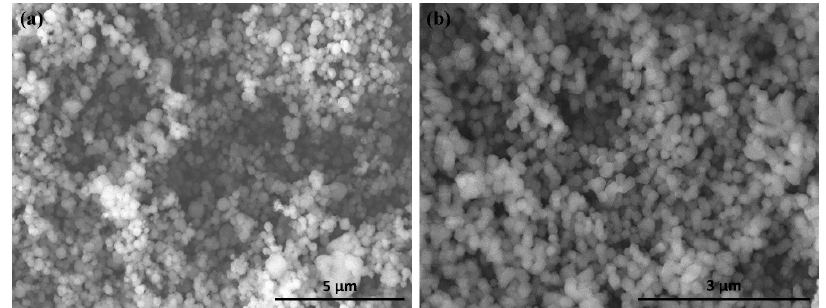
Figure 2. ( a ) Adsorption efficiency of heparin over ZIF-8 vs. ZIF-67 (conditions: 50 mL of 1000 mg L −1 heparin standard solution and 0.5 g of the adsorbent); ( b ) FTIR spectra of standard heparin, ZIF- 8, and preabsorbed heparin on the ZIF-8. 2.2. Heparin Adsorption Studies Prior to optimization, it was important to evaluate the affinity of heparin toward each absorbent in a pure heparin solution. The results (Figure 2a) demonstrated that ZIF-8 could adsorb more than 2-fold more heparin compared to ZIF-67 in a pure aqueous solu- tion. The reported BET surface areas for ZIF-8 and ZIF-67 are >1300 and ~316 m 2 /g, respec- tively [31,32], which are well correlated with their differences in adsorption efficiency. Due to the superior adsorption capabilities of ZIF-8 over ZIF-67, ZIF-8 was selected for further experiments to evaluate adsorption in real samples containing porcine intestinal mucosa. The FTIR spectrum of ZIF-8 shows a band at 1712 cm −1 , which confirms the pres- ence of C=N bond stretching. The bands at 1100 cm −1 and 990 cm −1 are attributed to C-N stretching. Additionally, a preabsorbed sample of ZIF-8 was dried and analyzed via FTIR spectroscopy so as to ensure that heparin adsorption occurred (Figure 2b). The resulting spectrum was compared with the FTIR spectrum of pure sodium heparin salt and the FTIR spectrum of ZIF-8 powder. The appearance of a band at 1712 cm −1 in the ZIF-8–hep- arin mixture is attributed to the C=O group of heparin, and the appearance of a band at 1222 cm −1 is attributed to the S=O group of heparin, which confirms the adsorption of heparin on the surface of ZIF-8.